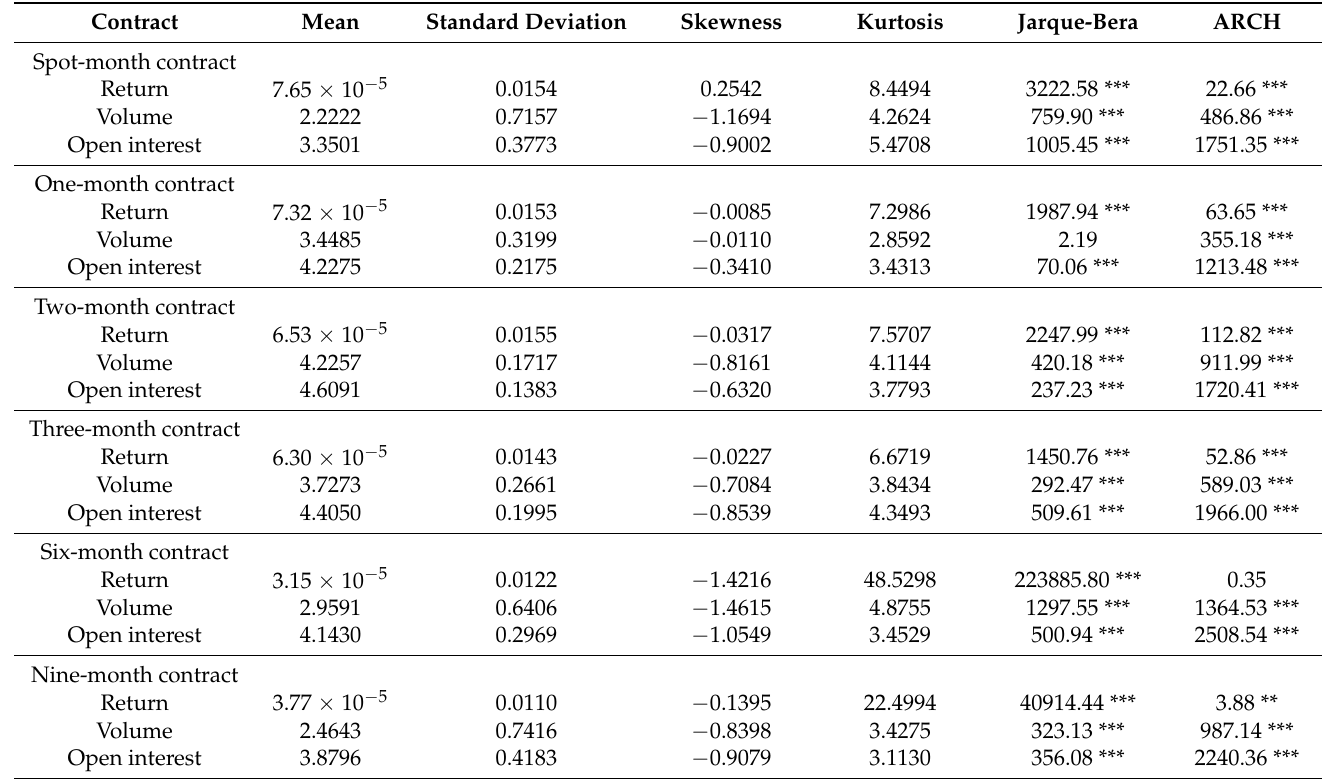
Table 1. Descriptive statistics of return, volume, and open